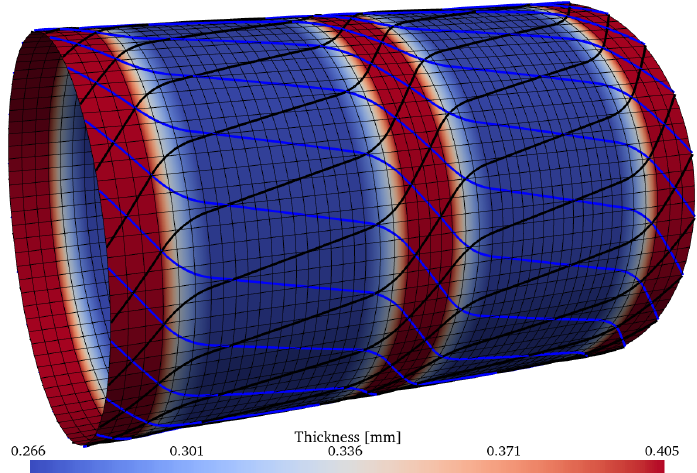
Figure 22. Optimum design ID = 12 from the Pareto front of Table 10, with m = 1.448 kg. The contour shows the thickness distribution. The black and blue lines represent, respectively, the CTS tow paths of each layer.